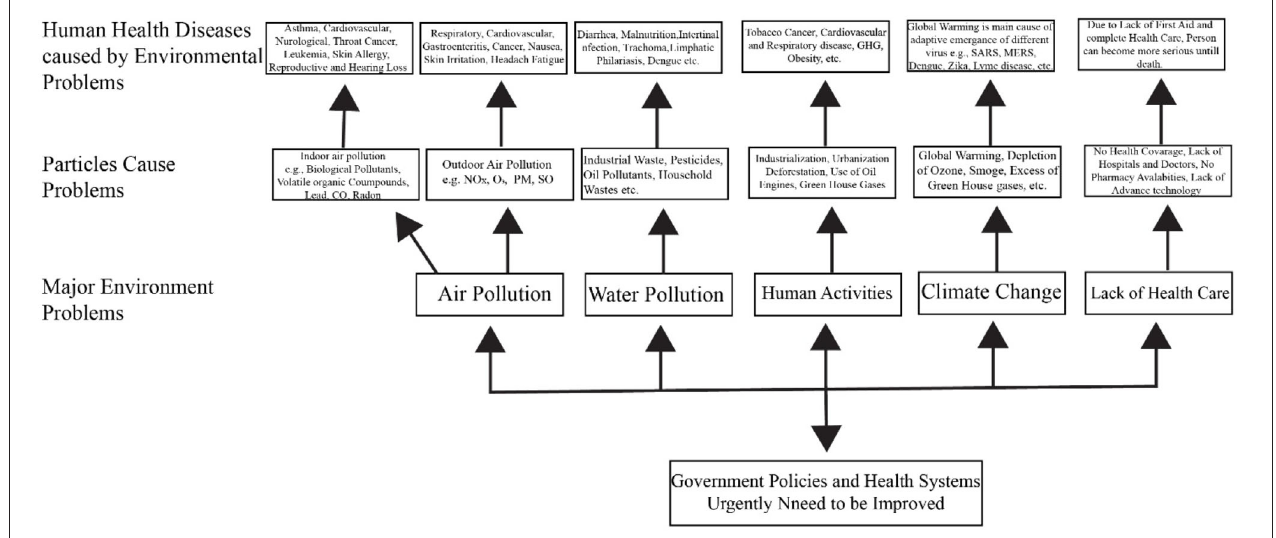
FIGURE 1 | Some major environmental problems and their pollutants cause major disorders in human